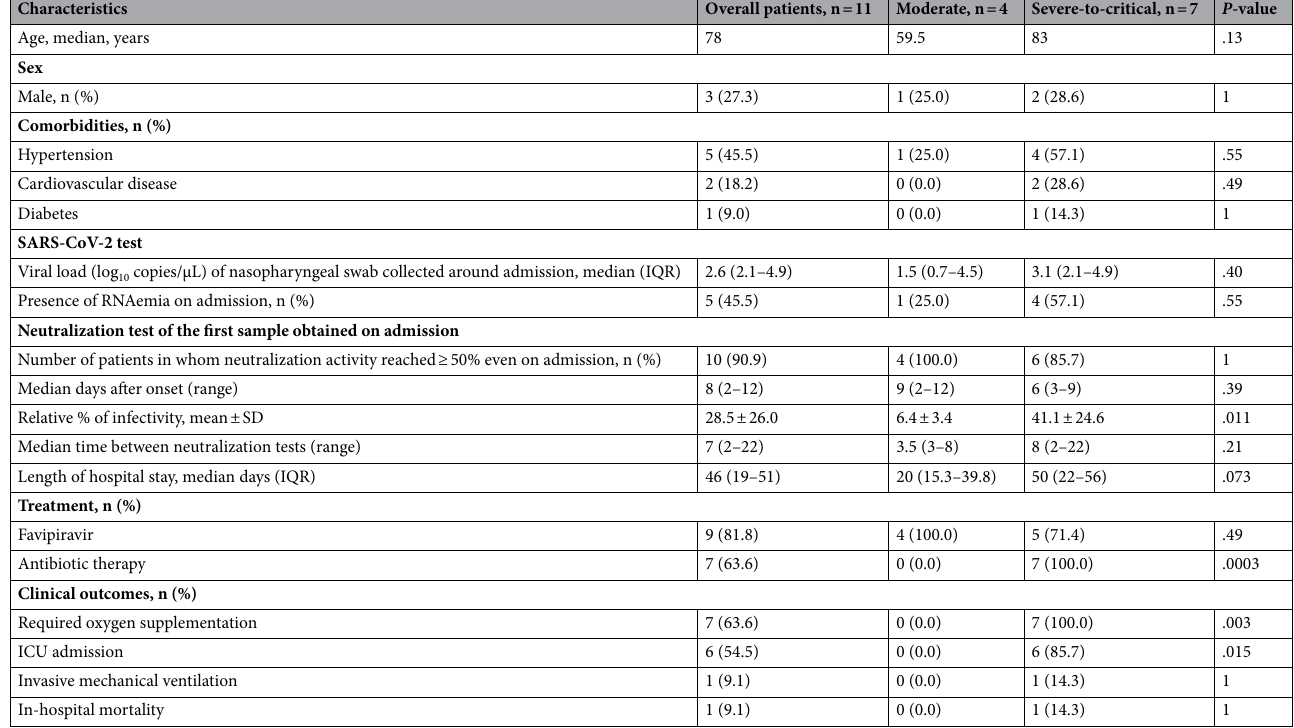
Table 1. Demographic, clinical characteristics, results of SARS-CoV-2 test, and neutralization antibody activities on admission of eleven patients stratified by